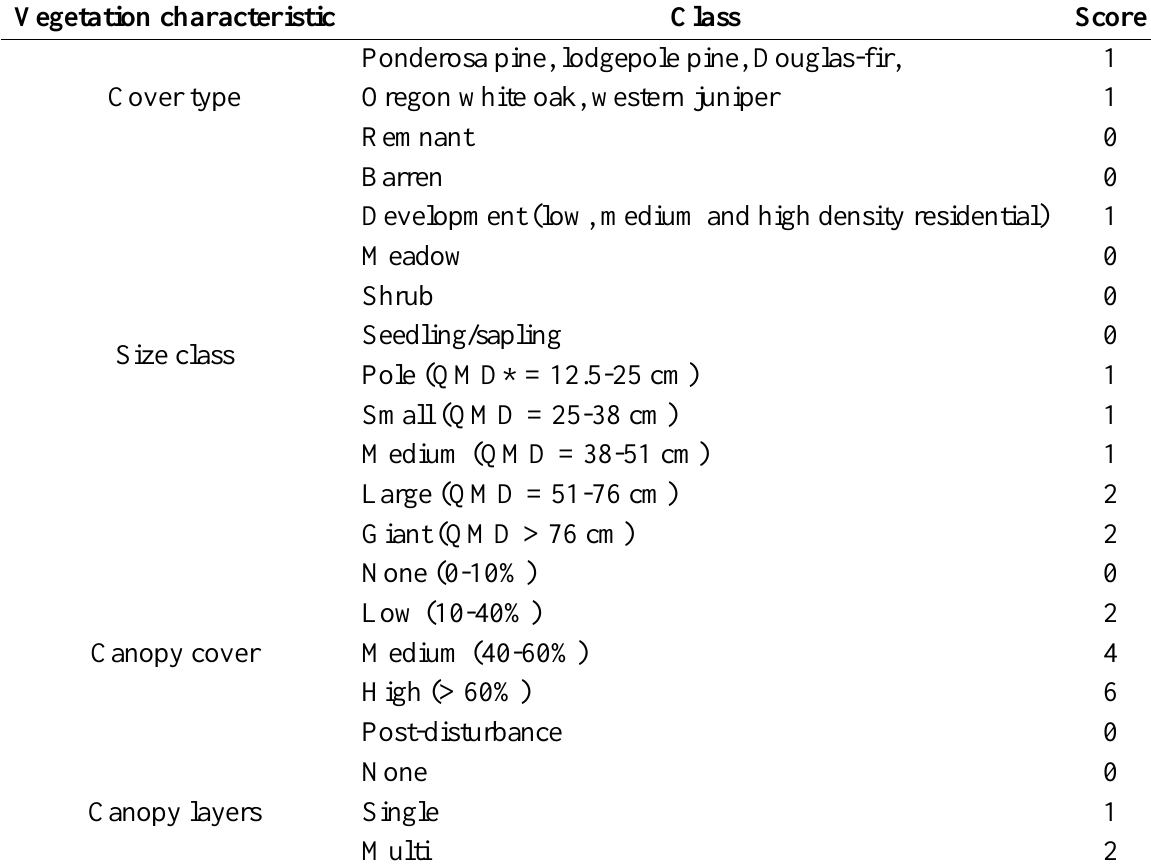
Table A10.4. Habitat model for mule deer: scoring system for thermal habitat. Vegetation